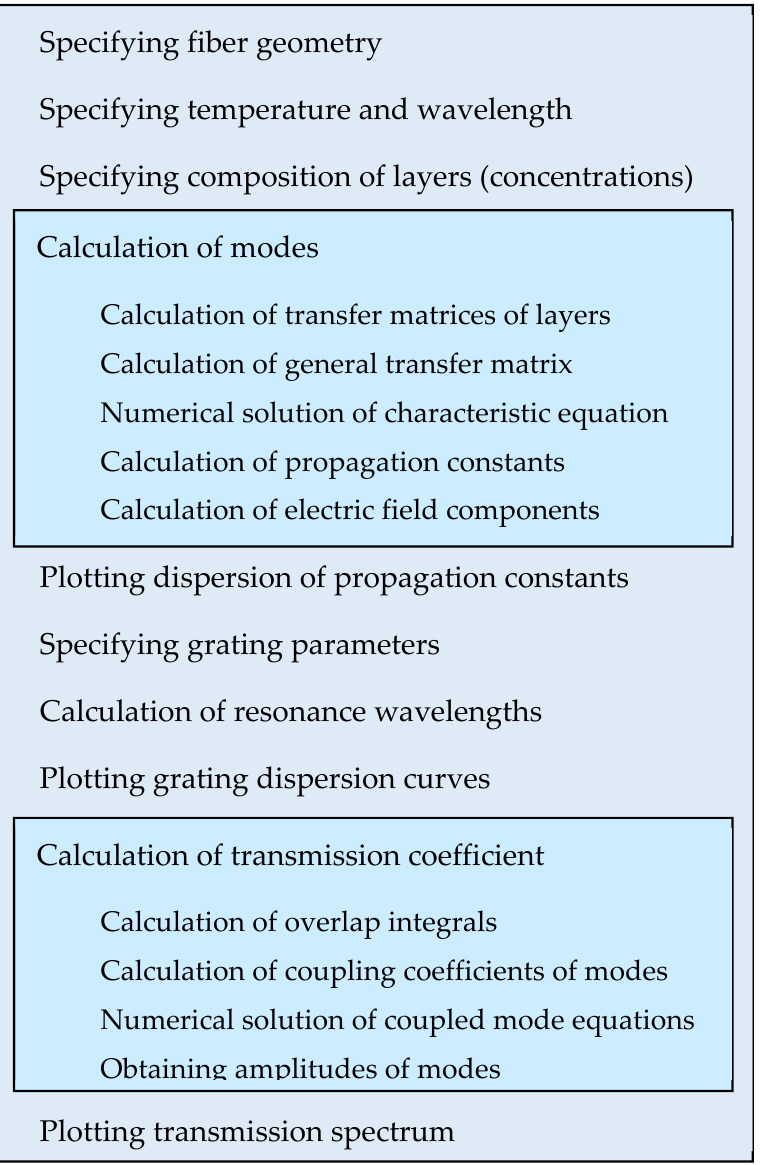
Figure 4. Schematic diagram of the simulations.